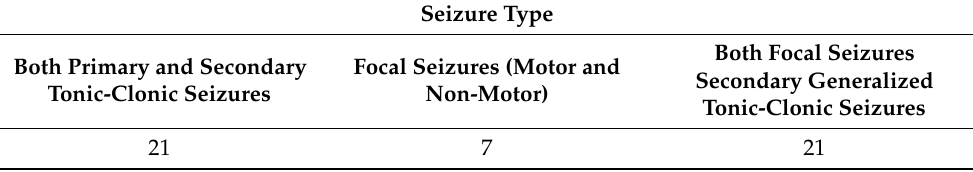
Table 3. Clinical characteristics of the patients–seizure type.